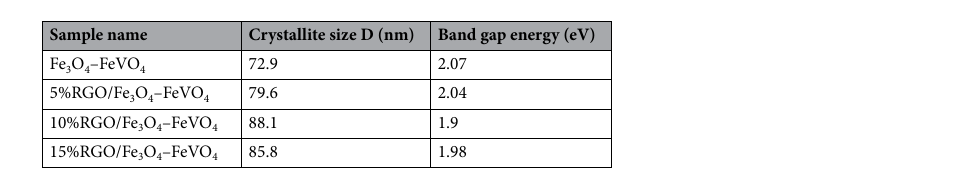
Table 1. Crystallite size and BG energy of the prepared